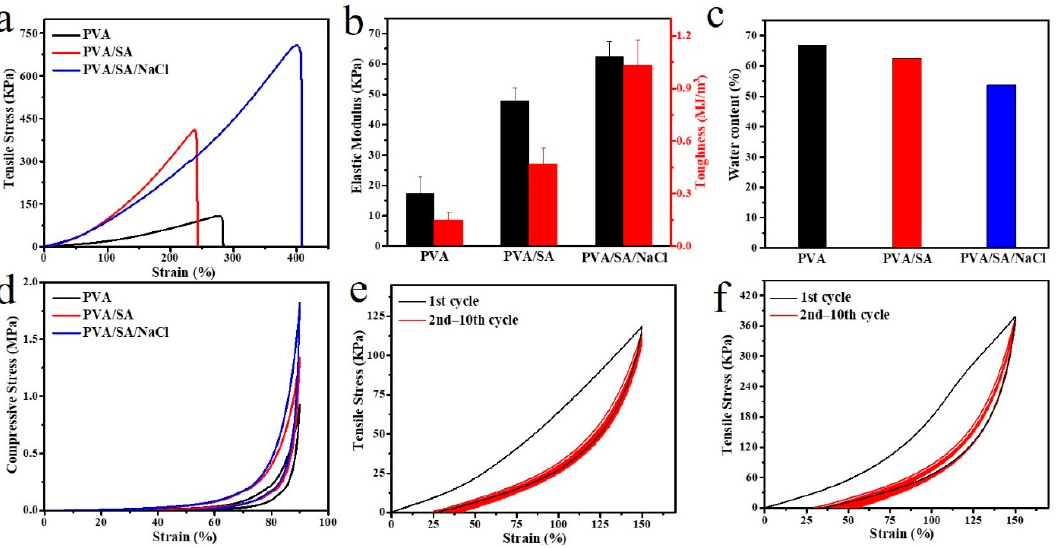
Figure 3. Mechanical properties of hydrogels. ( a ) Tensile stress–strain curves of the three types of hydrogels and ( b ) the calculated elastic modulus and toughness; each test was performed by pulling an un-notched sample to rupture. ( c ) The water content of the three types of hydrogels. ( d ) Compressive stress–strain curves at the strain of 90% of the three types of hydrogels. ( e ) Ten successive loading–unloading cyclic curves at the strain of 150% of the PVA/SA/NaCl hydrogel. ( f ) Recovered sample after storing for 3 h at room temperature. Error bars indicate the standard deviation, and n = 3.